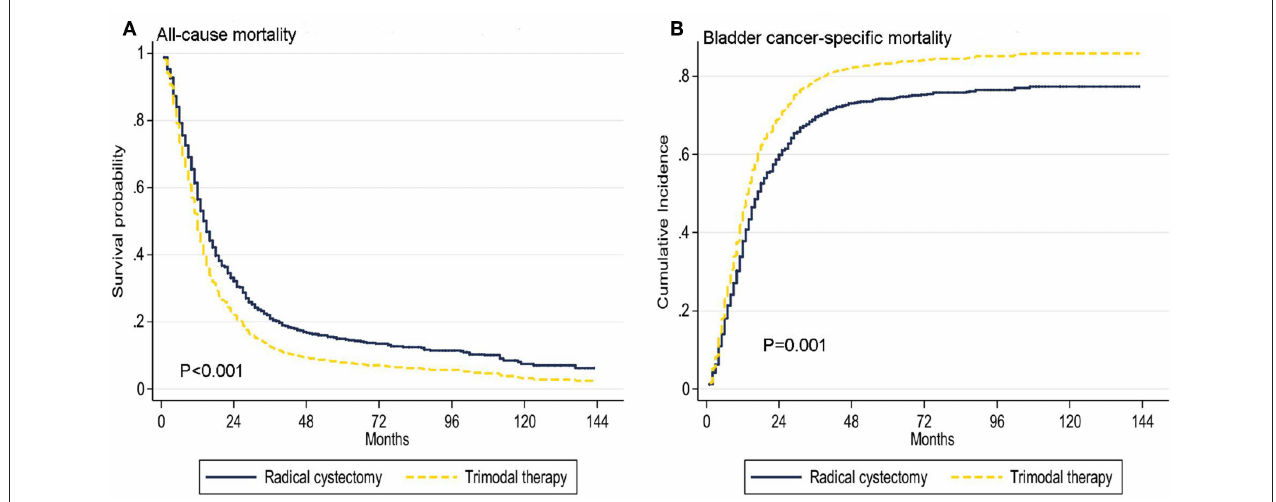
FIGURE 2 | Adjusted survival curves for all-cause mortality (A) and bladder cancer-specific mortality (B) by radical cystectomy (RC) and trimodal therapy (TMT) treatment options after